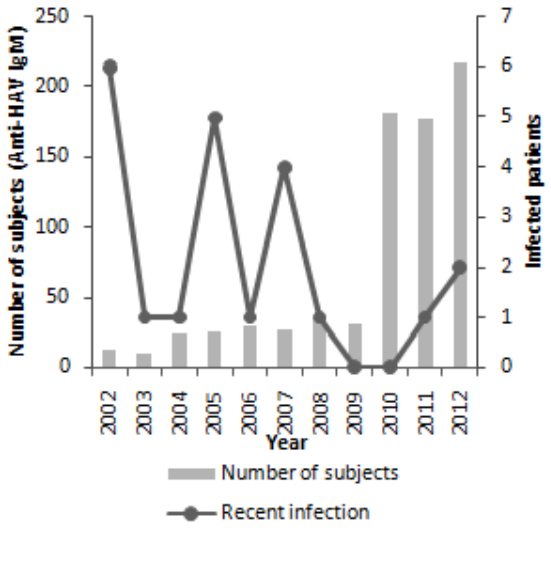
Figure 6. Number of infected patients by